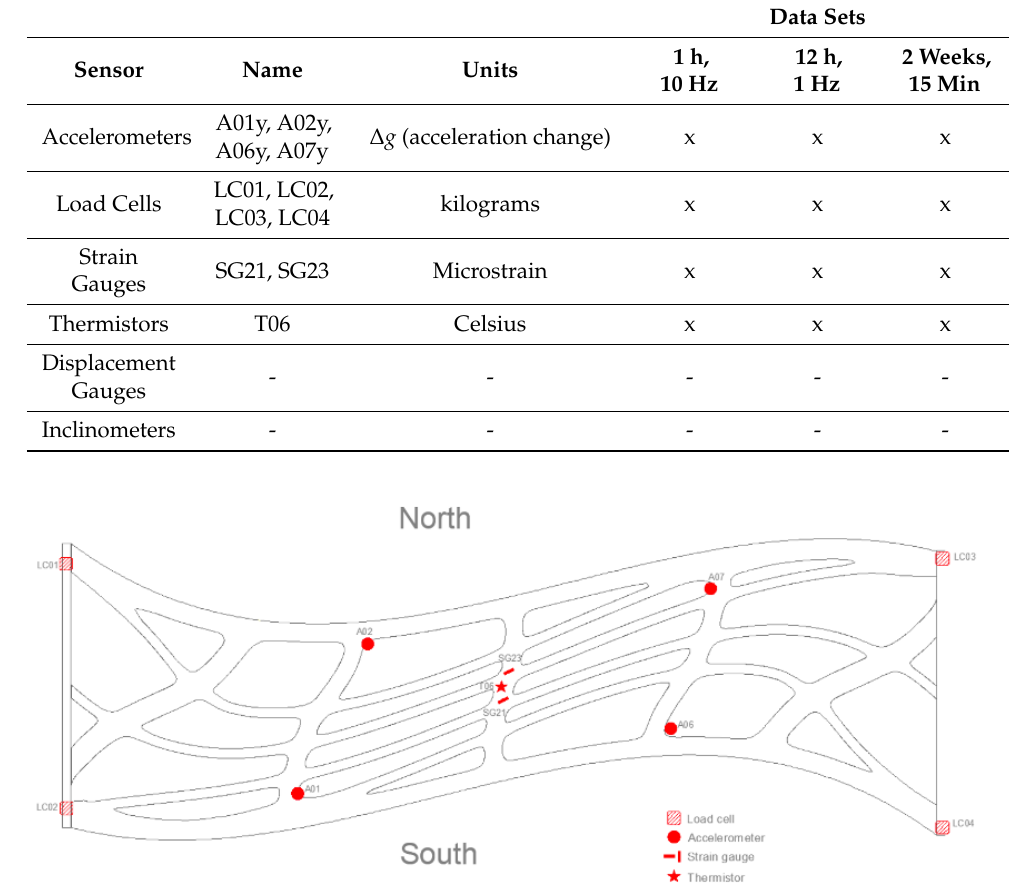
Figure 4. Public Dataset Sensor Locations.